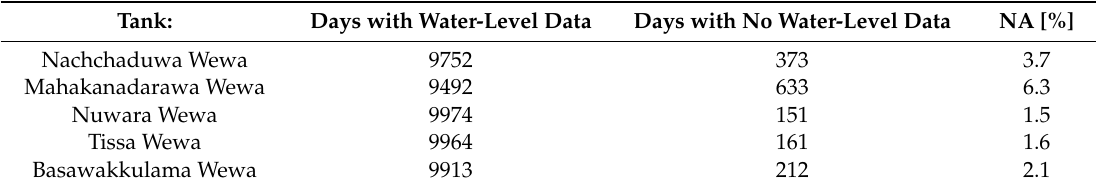
Table 2. Days of record and missing days for the water levels of the five tanks of interest in the period between 1 January 1990 and 20 September 2017 (10,125 days at all) provided by Irrigation Department, Sri Lanka. Tank: Days with Water-Level Data